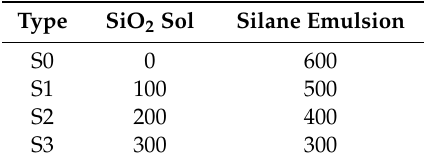
Table 3. Consumption of SiO 2 sol and silane emulsion on concrete surface (g/m 2 ).